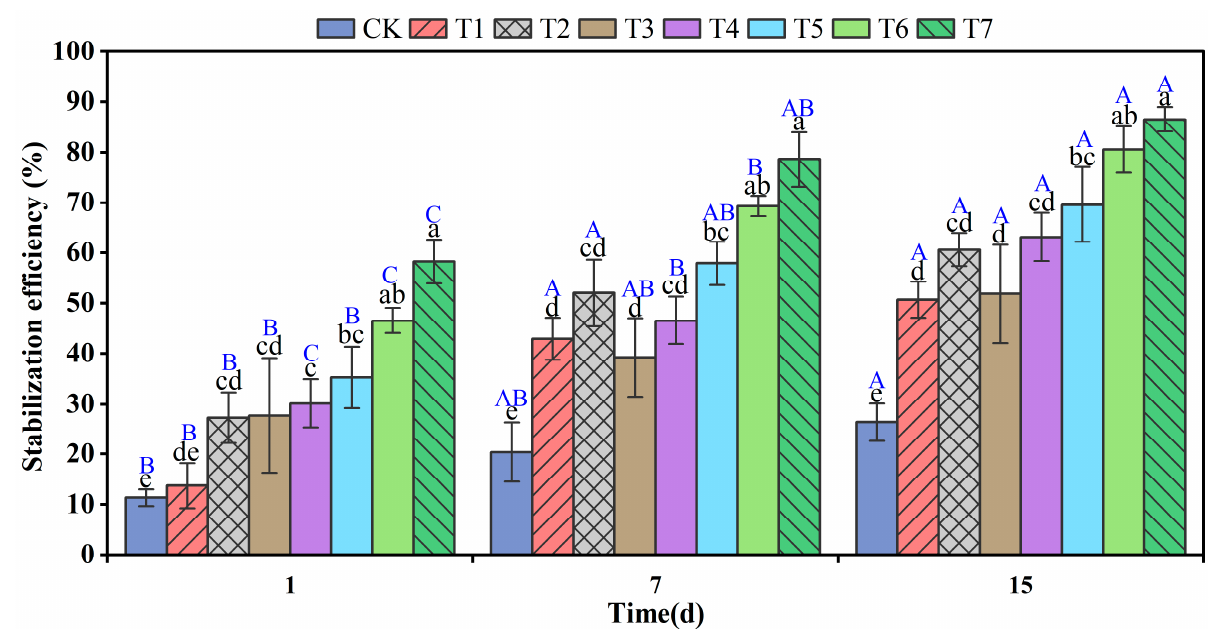
Figure 1. Effect of different times and treatments on the remediation of hexavalent chromium in soil (different capital letters represent significant differences between different times of the same treatment, different lowercase letters represent significant differences between different treatments at the same time, p < 0.05). (Soil without any additive (CK), RBC600, 10 g/kg (T1), nZVI, 10 g/kg (T2), BC-nZVI, 1 g/kg (T3), BC-nZVI, 3 g/kg (T4), BC-nZVI, 5 g/kg (T5), BC-nZVI, 7 g/kg (T6), BC-nZVI, 10 g/kg (T7)).